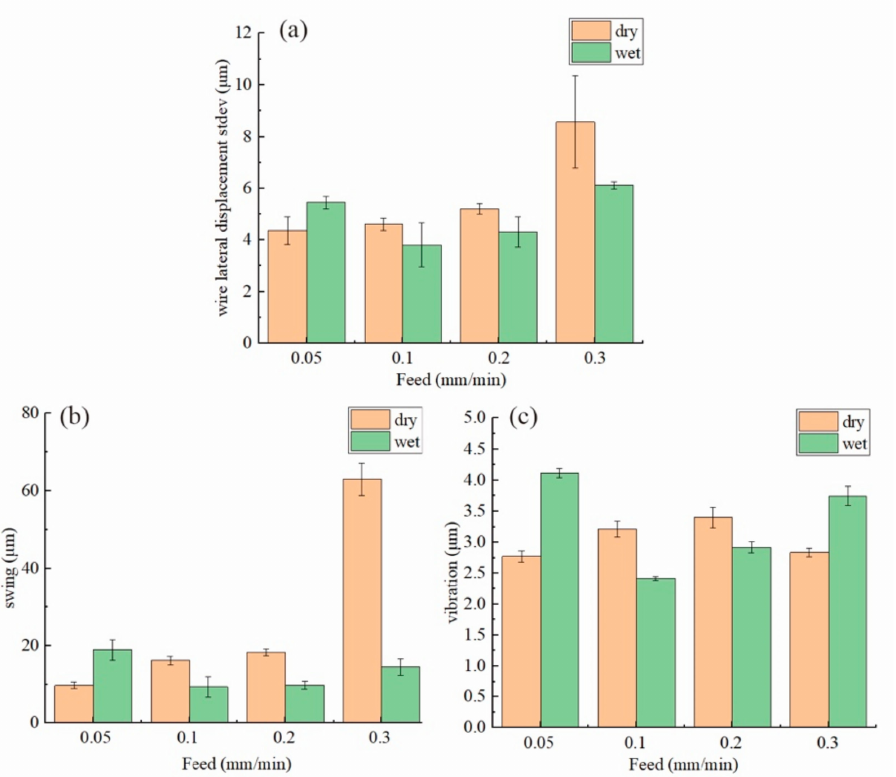
Figure 7. ( a ) The standard deviation of the wire motion data; ( b ) the PV for the swing component; ( c ) the standard deviation of the vibration component of the wire motion